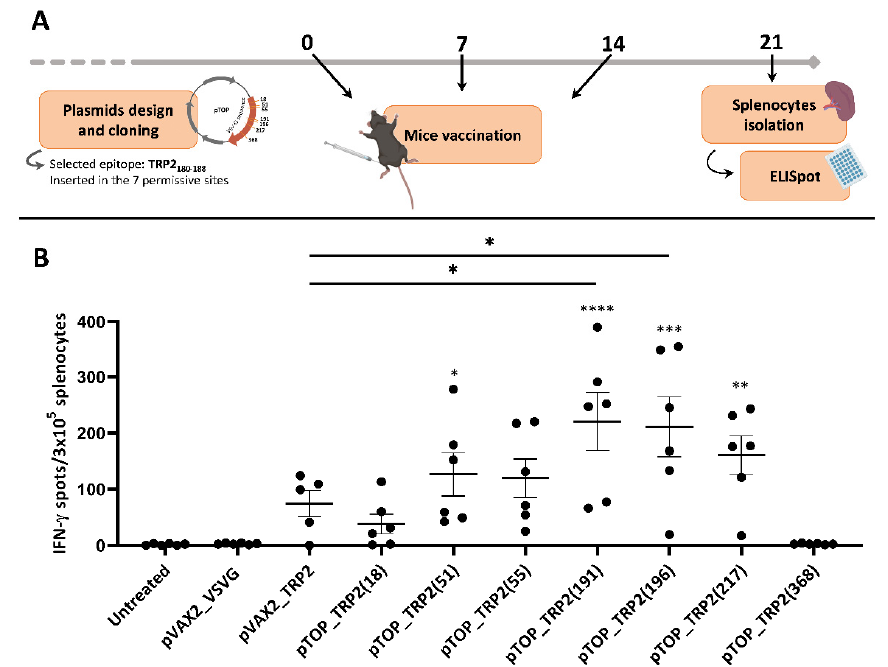
Figure 2. Influence of the insertion position of TRP2 180–188 epitope in pTOP. ( A ) Schematic protocol of experiments. Timing is expressed in days. ( B ) ELISpot results assessing the production of IFN- γ by splenocytes following stimulation with TRP2 180–188 peptide. Values are mean ± SEM; n = 5–6. Statistical analyses were performed using one-way ANOVA with Dunnet’s multiple comparison test (* p < 0.05; ** p < 0.01; *** p < 0.001; **** p < 0.0001, compared to the untreated group or to the specified group).